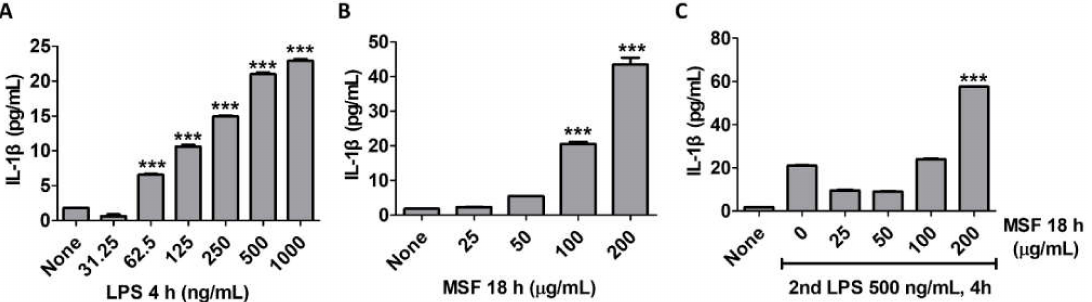
Figure 2. IL-1 β expression in THP-1 cells by MSF and LPS treatment. ( A ) THP-1 cells were treated with LPS at the indicated concentration for 4 h. ( B ) THP-1 cells were treated with MSF at the indicated concentration for 18 h. ( C ) THP-1 cells were pretreated with MSF at the indicated concentration for 18 h and then were retreated with 500 ng/mL LPS for 4 h. The level of interleukin (IL)-1 β in the culture supernatants was measured by ELISA. Statistical analysis was conducted with a one-way ANOVA followed by Tukey’s HSD post hoc test. *** p < 0.001.